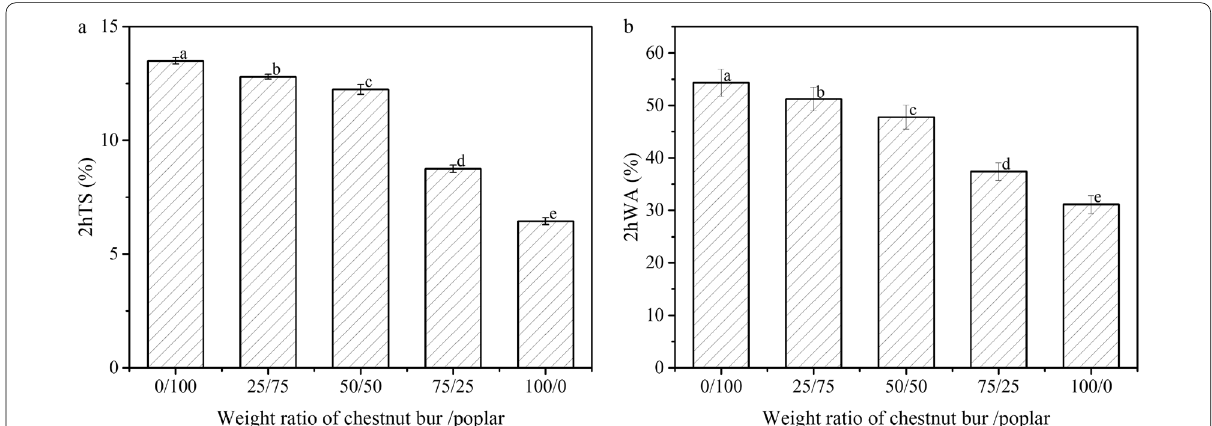
Fig. 7 Dimensional stability of composite particleboard. a The effect of the weight ratio of chestnut bur/poplar on the 2hTS of particleboard. b The effect of the weight ratio of chestnut bur/poplar on the 2hWA of particleboard. Error bars indicate standard deviations. Different letters in the figure indicate that means are significantly different ( p <